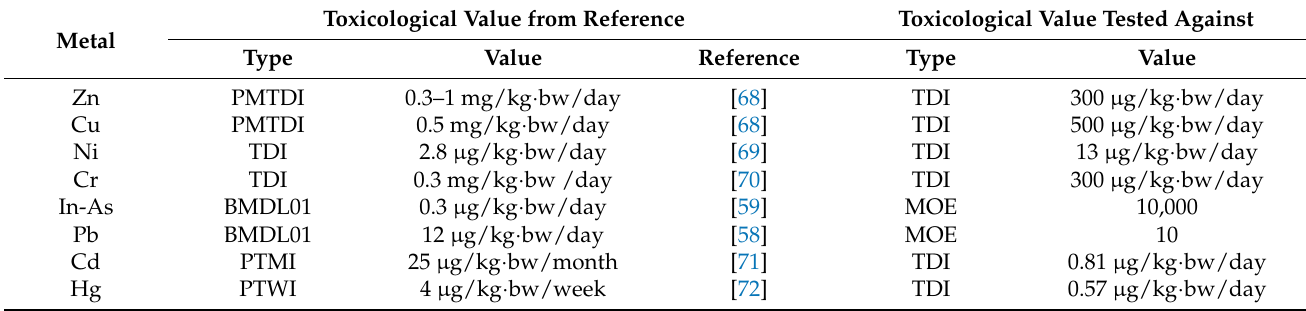
Table 1. Toxicological values for metals used for risk characterization, with PTWI being the provisional tolerable weekly intake and PTMI the provisional tolerable monthly